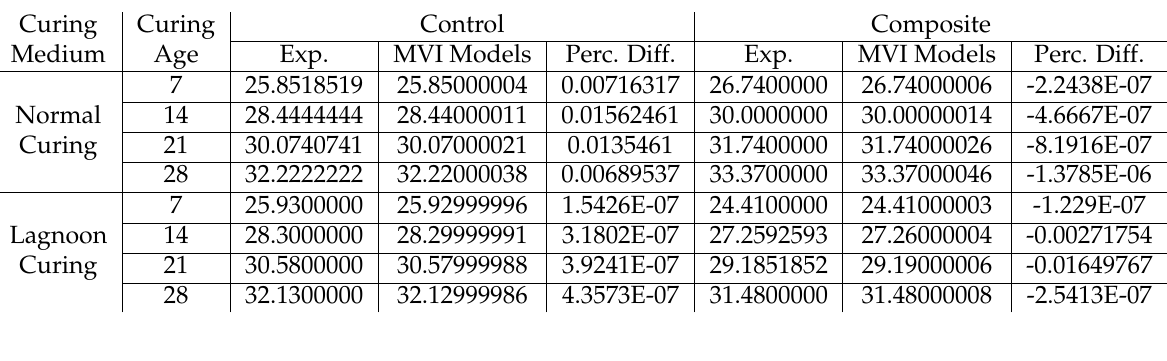
Table 6. Validation of developed mathematical models for the compressive strength of pozzolan blended steel slag aggregate concrete using MVI method